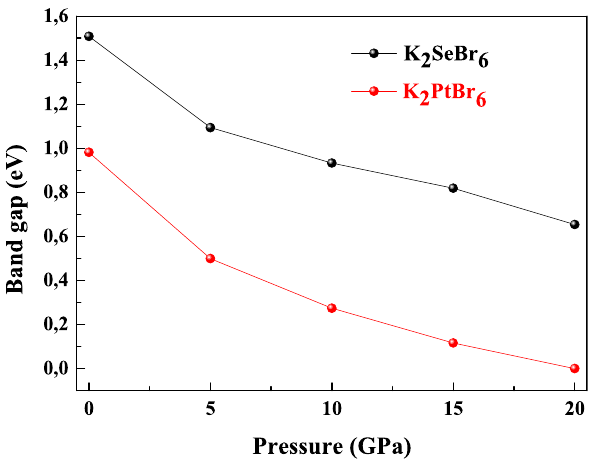
Figure 8. Fundamental band gap of K 2 XBr 6 (X = Pt, Se) with GGA (PBE-SOL) and HSE